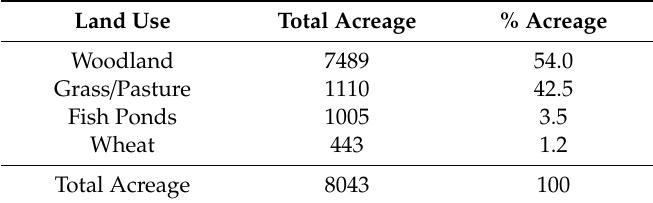
Table 3. Summary of land use within a two-mile radius around the Low-Ag site in